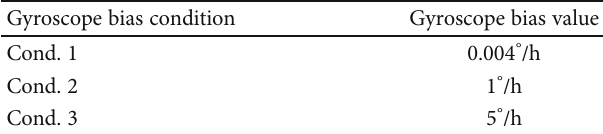
Table 2: Three gyroscope bias